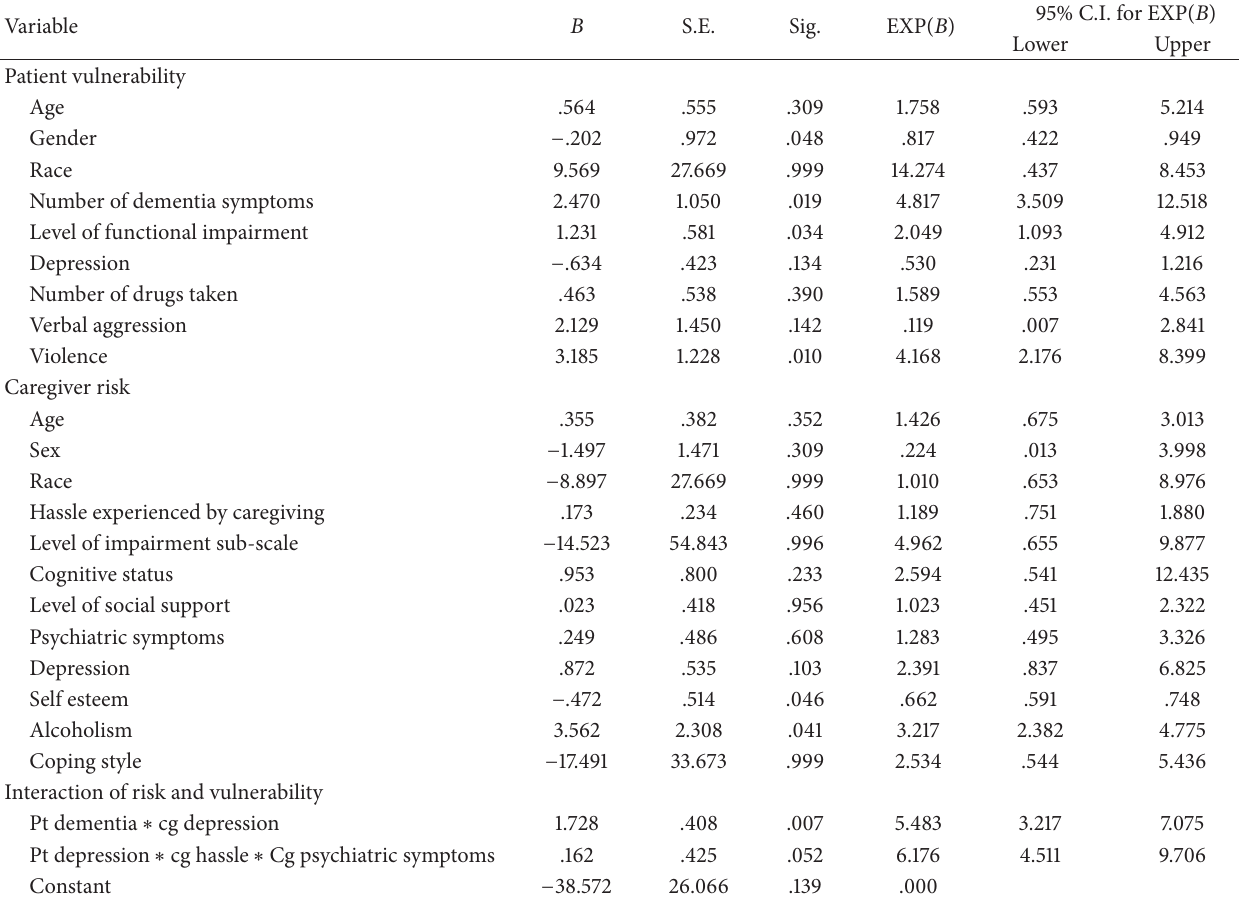
Table 3: Logistic regression analysis: violent caregivers versus all others ( 𝑛 = 254